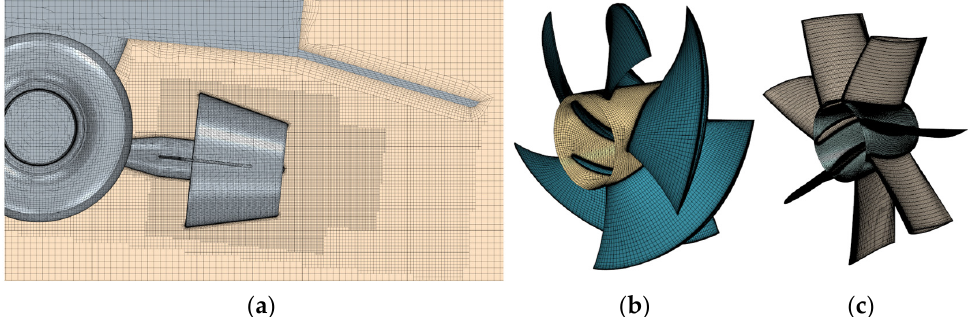
Figure 6. The mesh of self-propulsion numerical simulation. ( a ) Pump-jet mesh; ( b ) Rotor mesh; ( c ) Stator mesh.